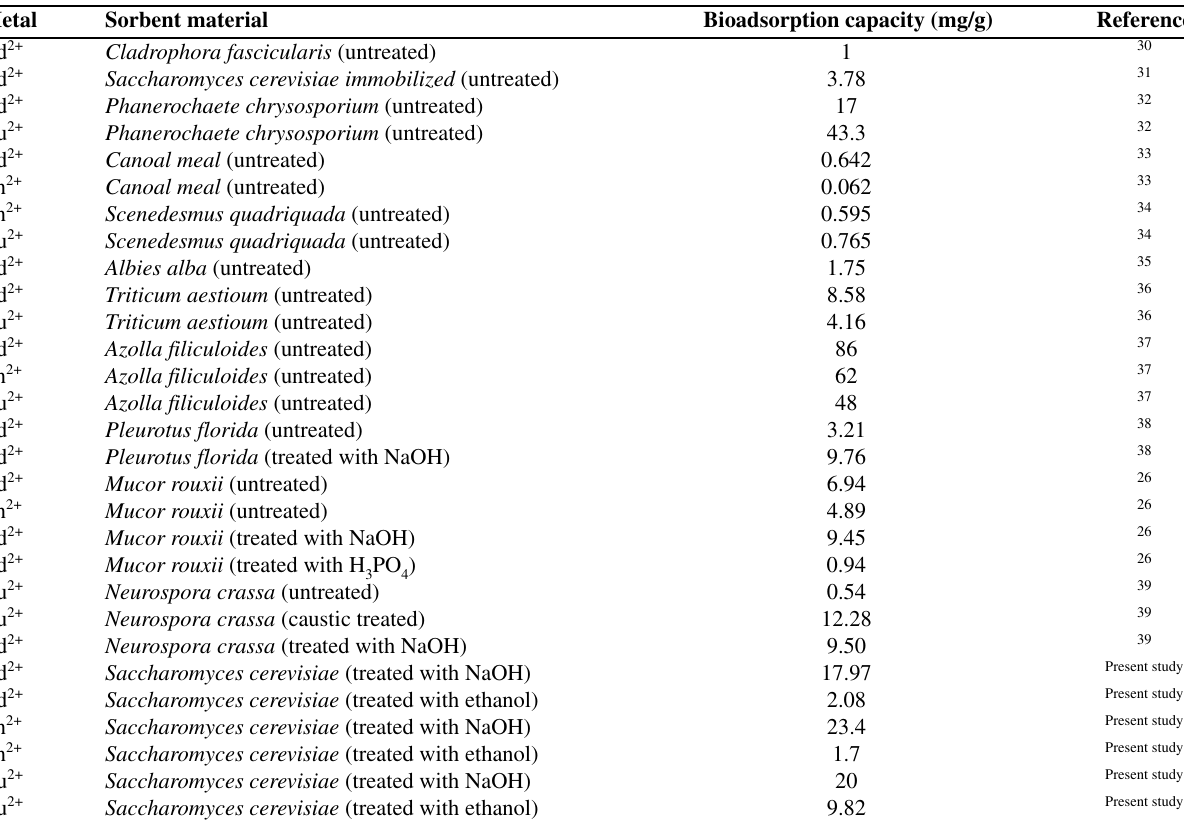
Table 3. Results from the literature: comparison of different biomasses regarding to Cd 2+ , Zn 2+ and Cu 2+ removal capacity. Metal Sorbent material Bioadsorption capacity (mg/g)